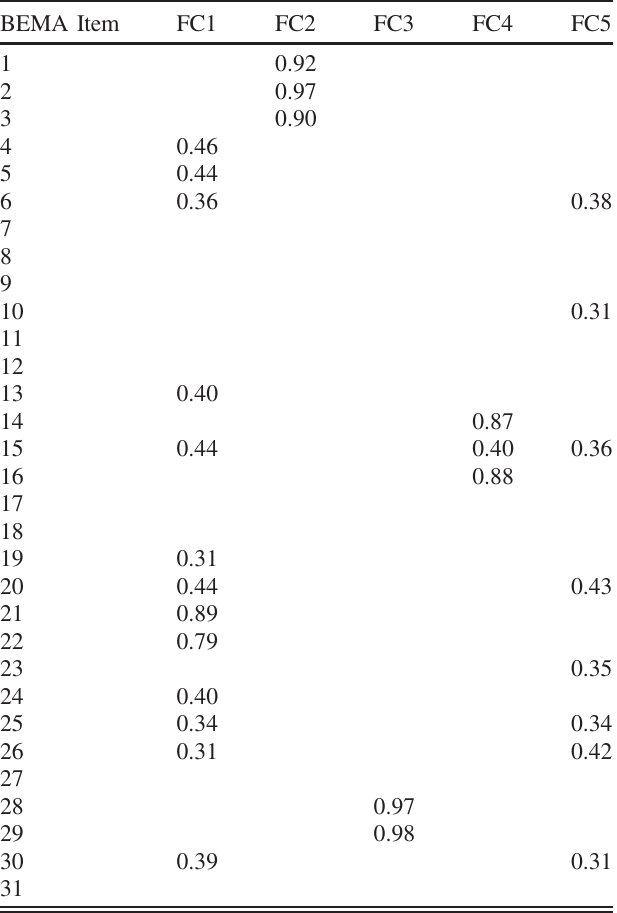
TABLE II. Factor structure for the five-factor model. Only loadings greater than 0.3 are shown. The factors are labeled FC1 to